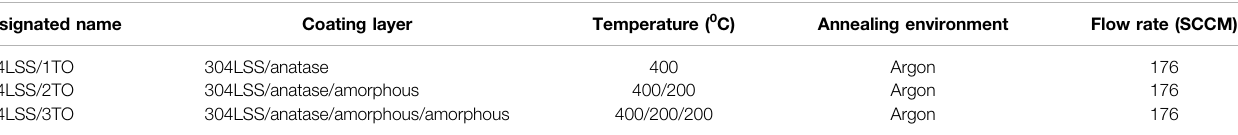
TABLE 2 | Annealing treatment conditions for TiO 2 over